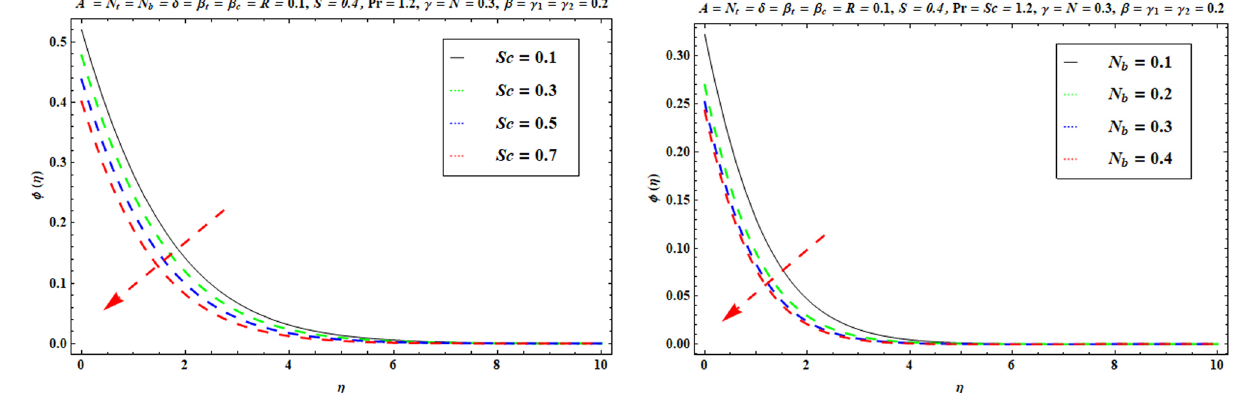
Figure 15: ϕ η ( ) versus Sc.